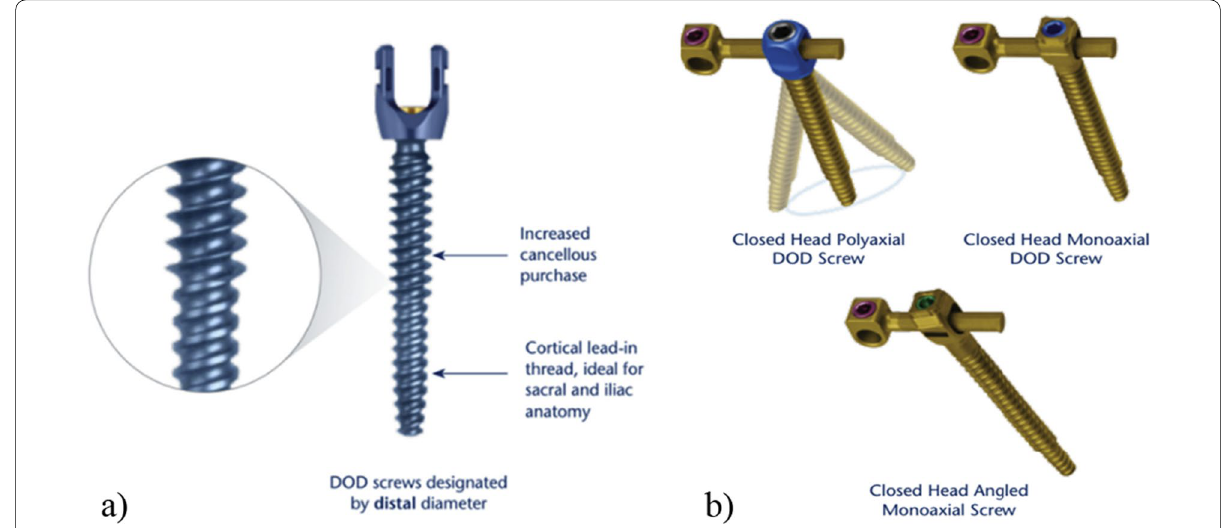
Fig. 19 a DOD screws. b Closed head polyaxial, monoaxial, and angled monoaxial DOD screws